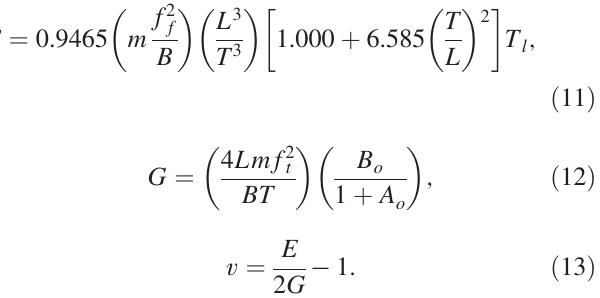
TABLE IV. Mean resonance testing flexural frequency f modulus E [GPa], shear modulus G [GPa], and Poisson ’ s ratio v , for CuCD, MoGr, and CFC along ( L ), ( T ), and ( P ). Insert type